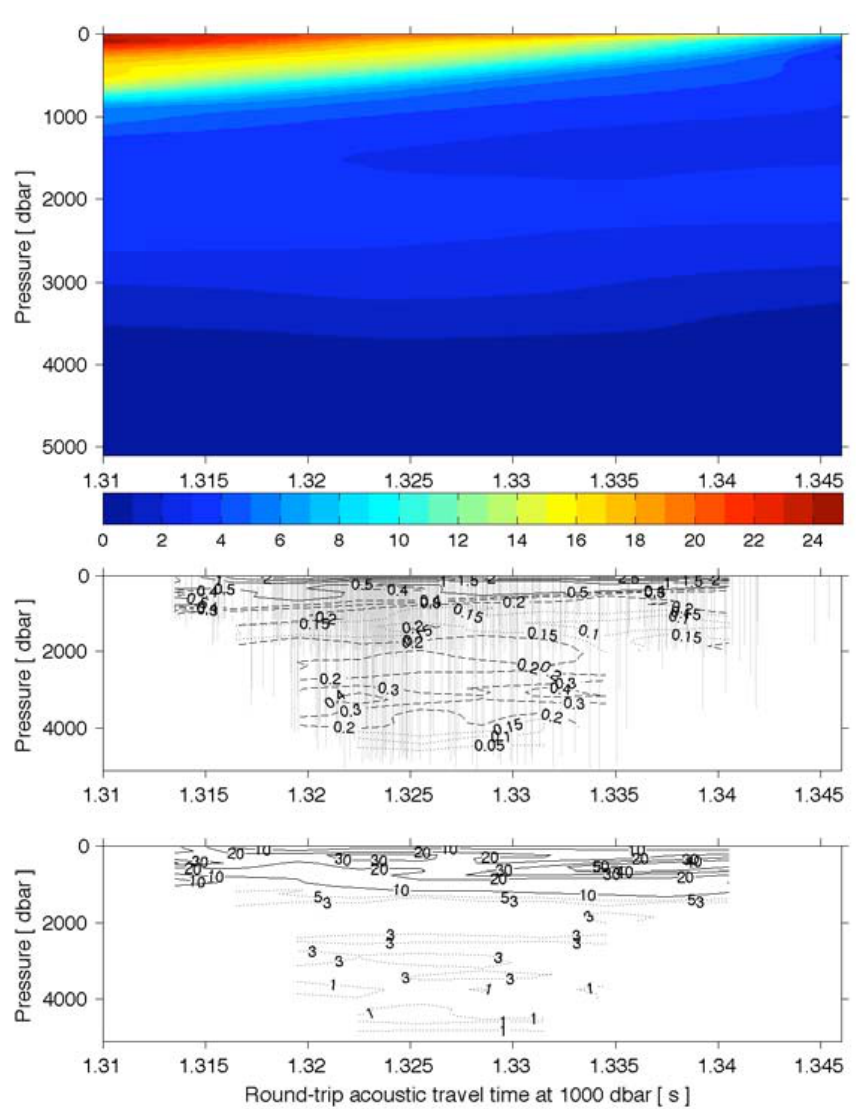
Fig. 2. Upper panel: two-dimensional look-up table of temperature as a function of pressure and simulated travel time between the surface and 1000dbar created via the GEM method (see text). Middle panel: root-mean-squared (rms) difference between the directly measured CTD or Argo profile temperatures ( ◦ C) and the corresponding GEM estimates determined using the GEM field and the simulated travel time determined from the CTD/Argo temperature and salinity profiles. The rms differences are determined in bins of 3ms with and 100dbar height. Gray dotted lines indicate CTD data availability. Lower panel: the rms scatter scaled as a signal-to-noise ratio based on the observed signal at each pressure level.